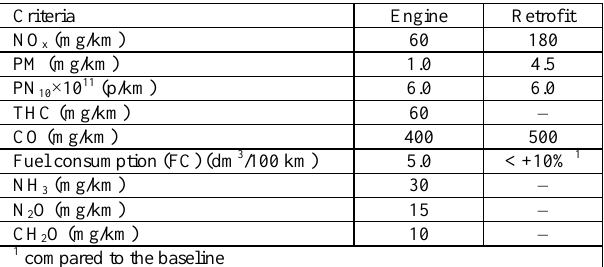
Table 1. Threshold values for the initial testing by the applicant